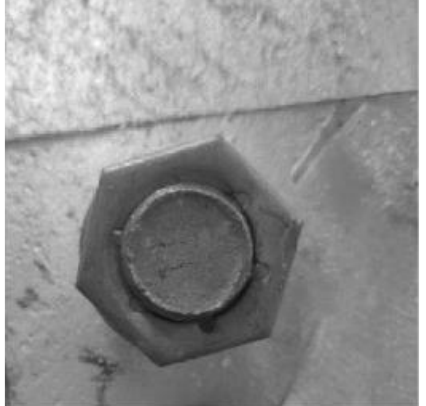
Figure 6. Grayscale image.